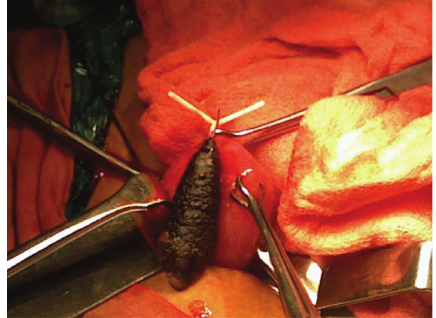
Figure 3: Complete removal of the stone along with the projecting horizontal limb of the intrauterine